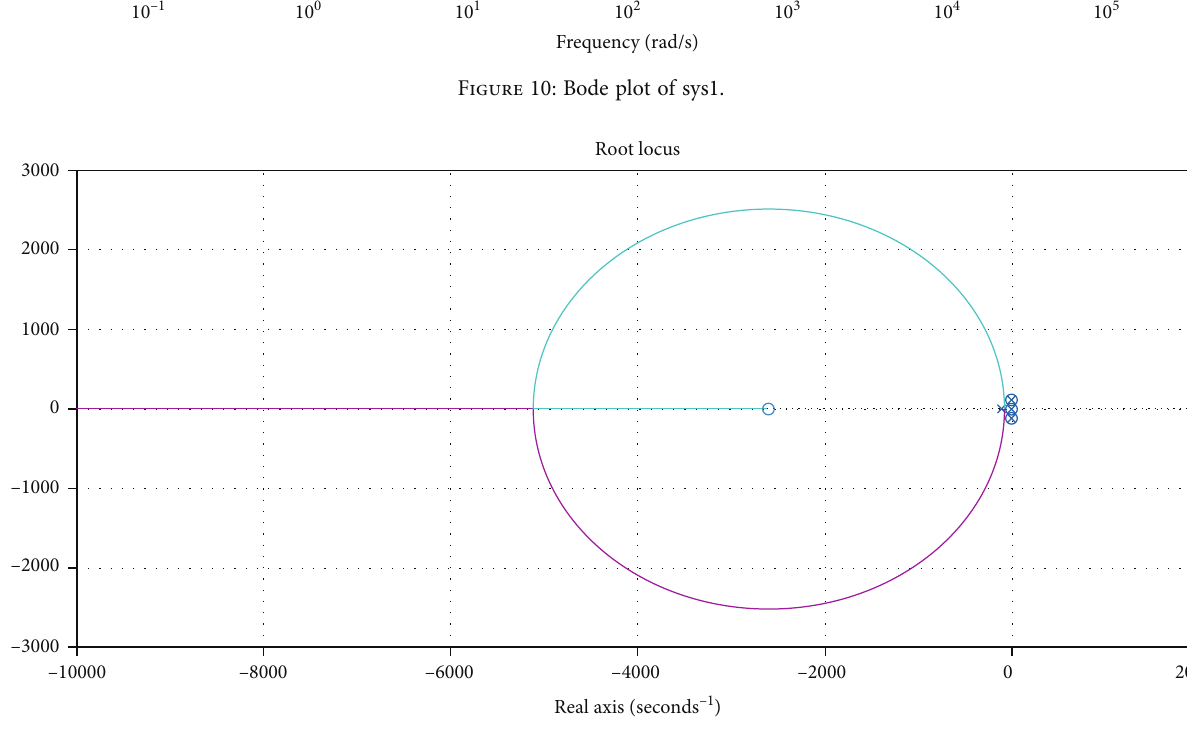
Figure 11: Root Locus of sys1